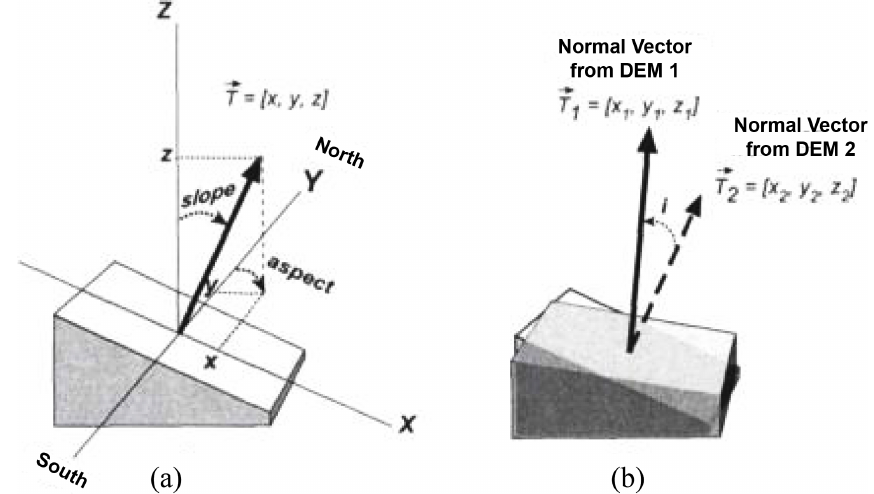
Figure 17. Normal vector of a topographic surface (a) and the angular difference between two normal vectors (b) (Hodgson and Gaile, 1999).